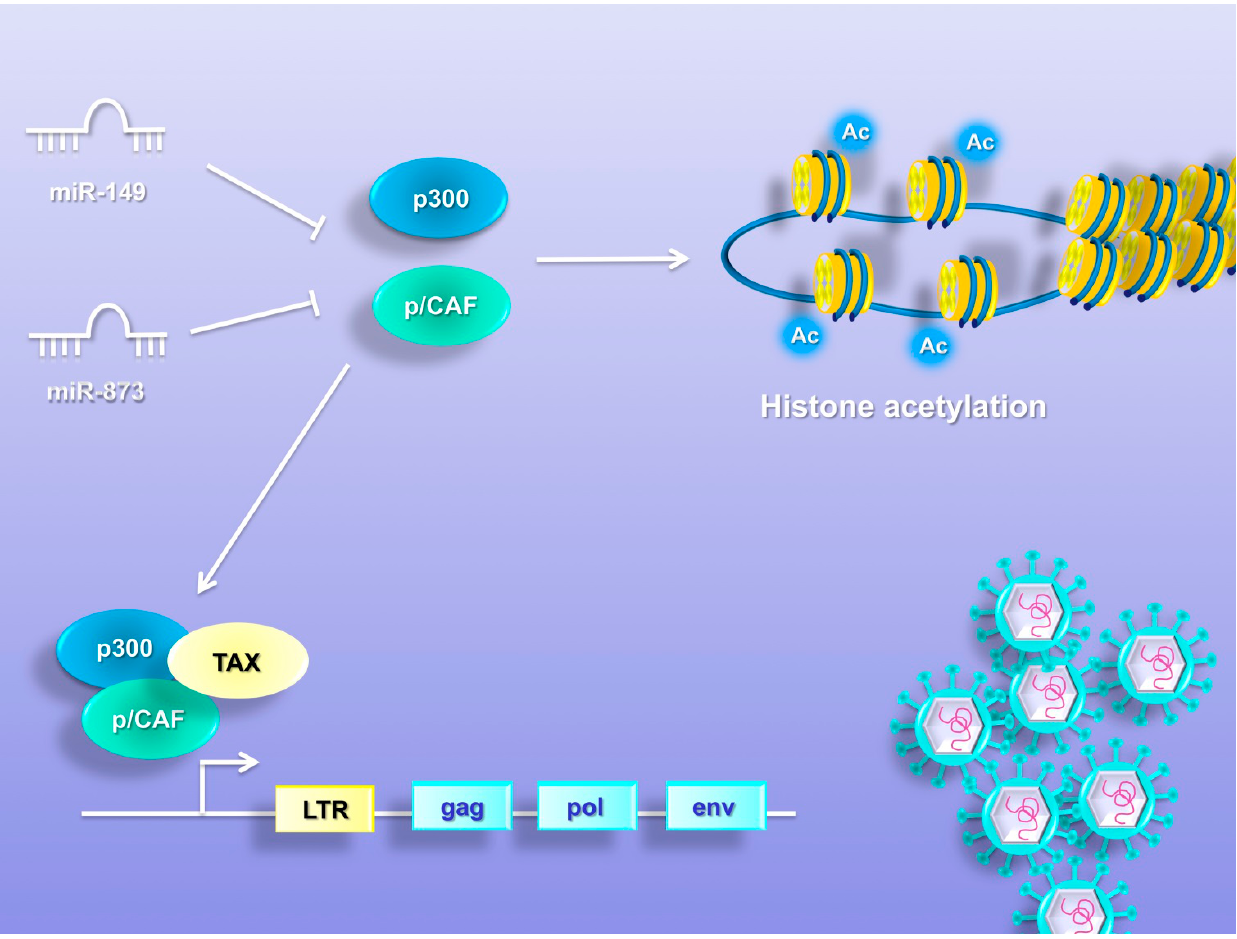
Figure 5. MiR-149 and miR-873 promote chromatin remodeling. The Tax protein promotes HTLV-1 gene expression by its interaction with the long terminal repeat (LTR) or U3 region of the viral promoter. To activate the transcription, Tax recruits the p300/CREB-binding protein (p300/CBP) and p300/CBP-associated factor (P/CAF), which bind two different regions of Tax, resulting in histone acetylation and chromatin remodeling. MiR-149 and miR-873 are downregulated in HTLV-1-transformed cell lines and target the chromatin remodeling factors p300 and p/CAF.